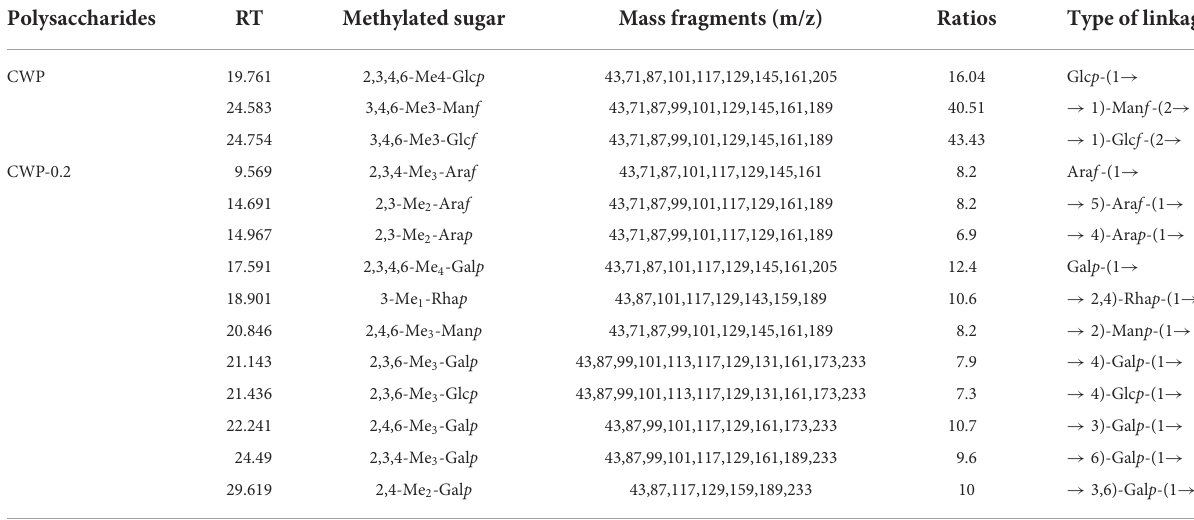
TABLE 2 Monosaccharide linkage analysis of CWP and CWP-0.2 (molar ratios %). Polysaccharides RT Methylated sugar Mass fragments (m/z) Ratios Type of linkage CWP